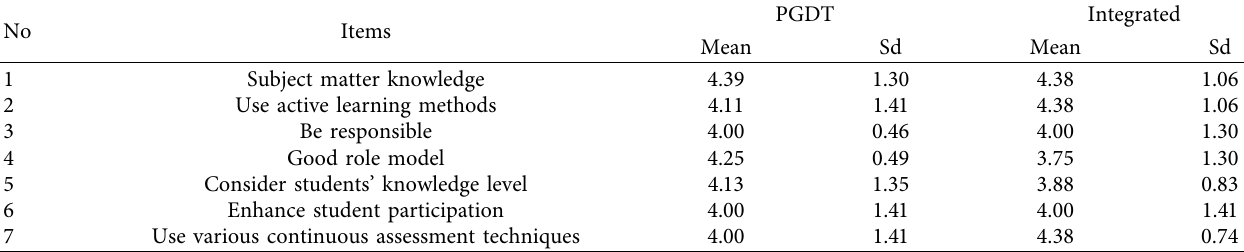
Table 3: Teachers’ perceptions on the effectiveness of PGDT and integrated curriculum.